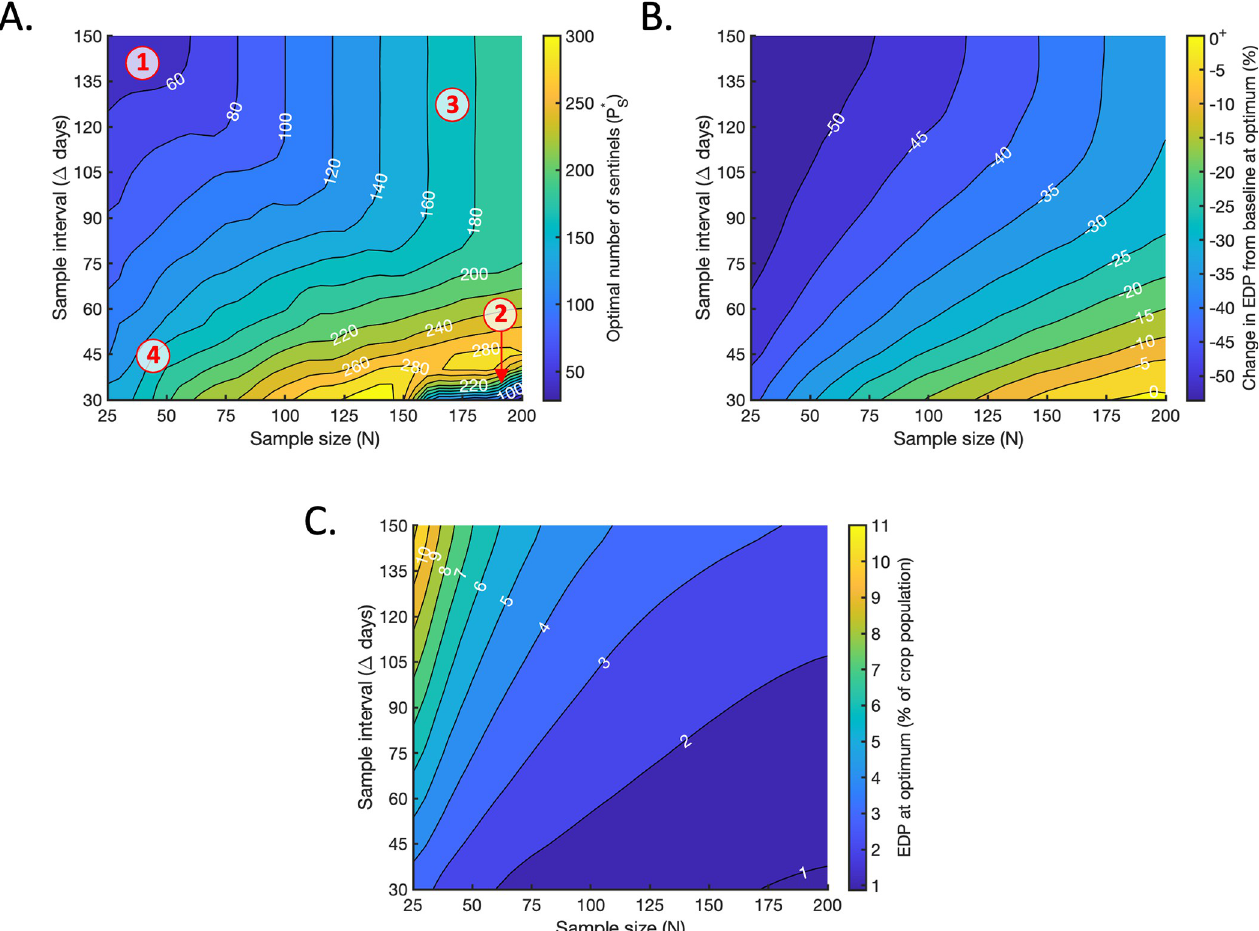
Fig 5. Optimising the number of sentinels to include in the population. A. The optimal number of sentinel plants to include in the population, P � , for which S the maximal reduction in the EDP compared to the baseline level is achieved (if N S is also chosen optimally). Region 1: When the sampling effort was small, P � S was low. P � increased for larger sample sizes (moving to the right on the figure) and smaller sample intervals (moving downwards on the figure). Region 2: P � S S dropped again when the sampling effort was very high. In that region, the baseline EDP was very low (Fig 2C), and the scope for reducing it insufficient to offset the increase in transmission rate caused by adding large numbers of sentinel plants into the population. Region 3: When the sample interval ( Δ ) was large, the optimal number of sentinel plants to include in the population was equal to the sample size ( N ) (contour lines are vertical). In that region, the sample interval was long enough to allow for repeated sampling of the same plants, eliminating the need for P to exceed the sample size. Region 4: When the sample S interval ( Δ ) was small, the optimal total number of sentinels in the population was substantially larger than the sample size. In that region, a large sentinel population was necessary to avoid frequent repeated sampling of the same plants. B. The percentage change in the EDP compared to the baseline value at the optimum, achieved when P ¼ P � and N ¼ N � . C. The resultant value of the EDP at the optimum, expressed as a percentage of the total crop population. S S S S